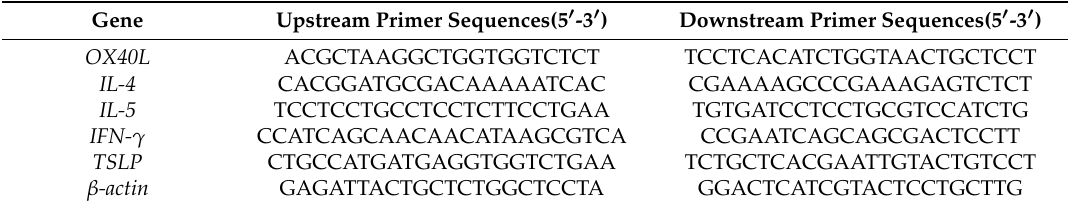
Table 1. Upstream and downstream primer sequences of